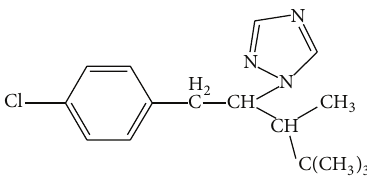
Figure 1: The chemical constructure of